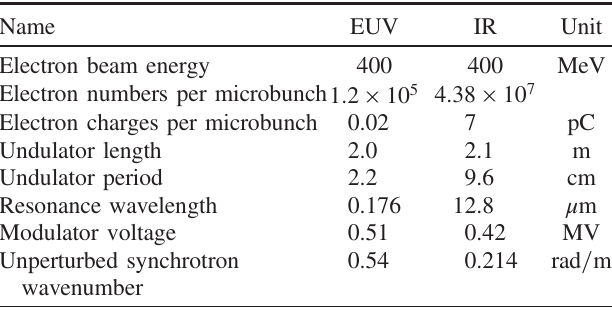
TABLE I. Relevant beam and undulator parameters for the two examples EUV and IR.